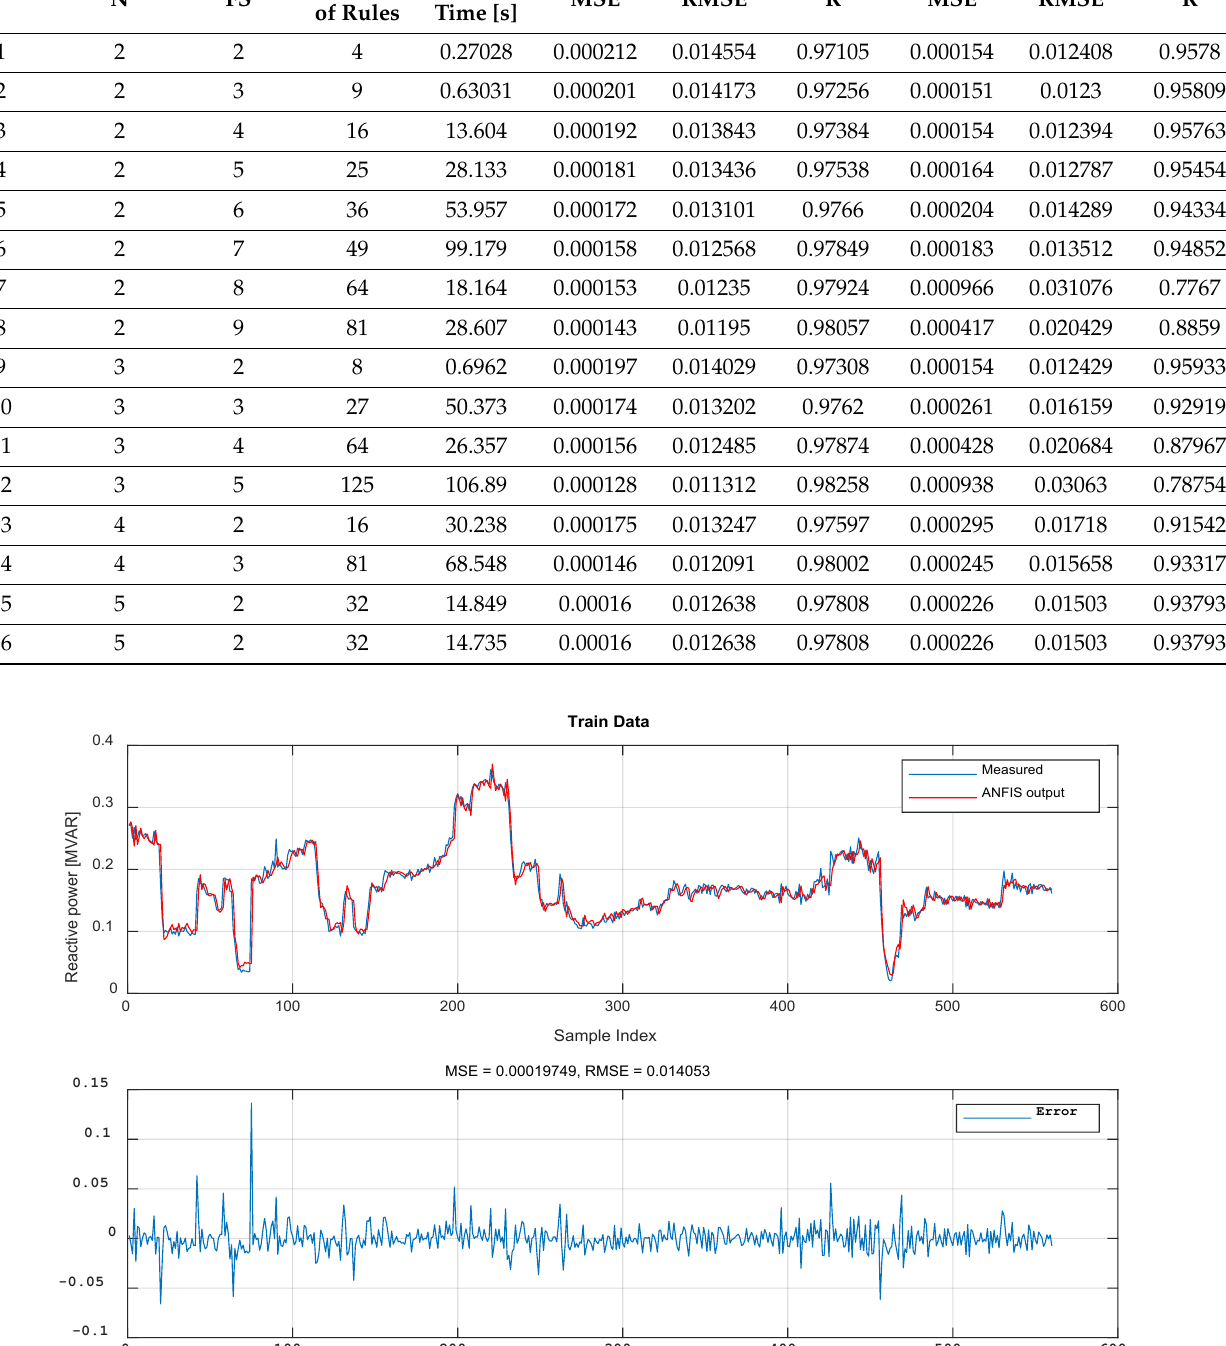
Figure 9. The variation of the measured and predicted reactive power, and also of the error for modelling with ANFIS grid partition method for testing stage.